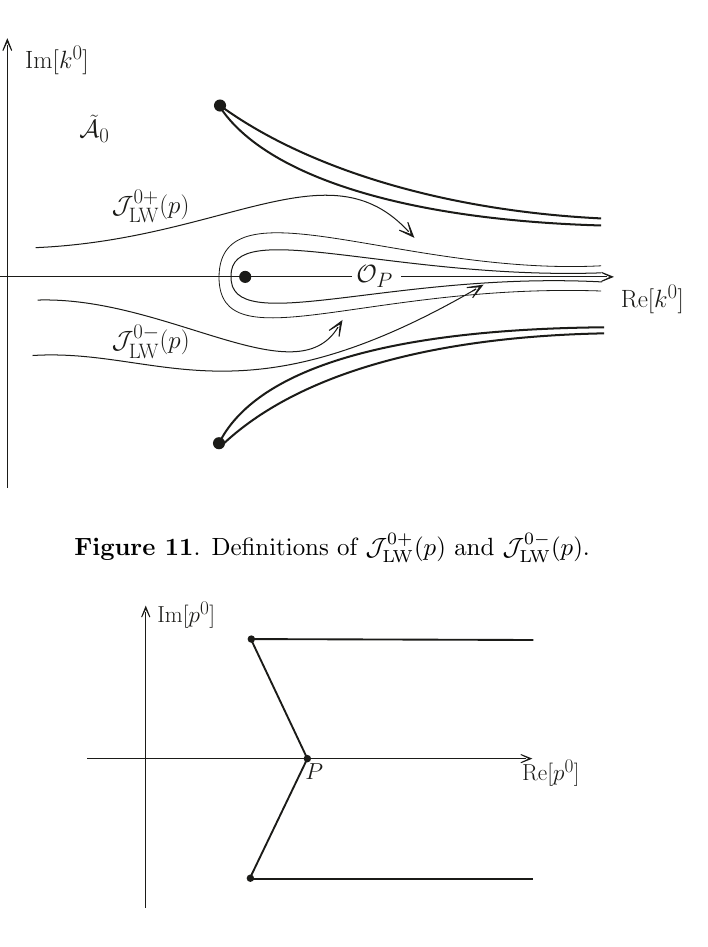
Figure 12 . Final analytic regions